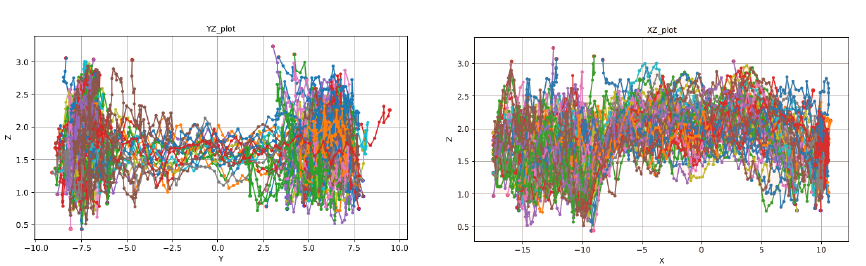
Figure 16. These diagrams illustrate the navigation of UAV using trained SCAN in the challenging environment. The left image shows the trajectory of UAV navigation in the YZ plane. The right image shows the trajectory of UAV navigation in the XZ